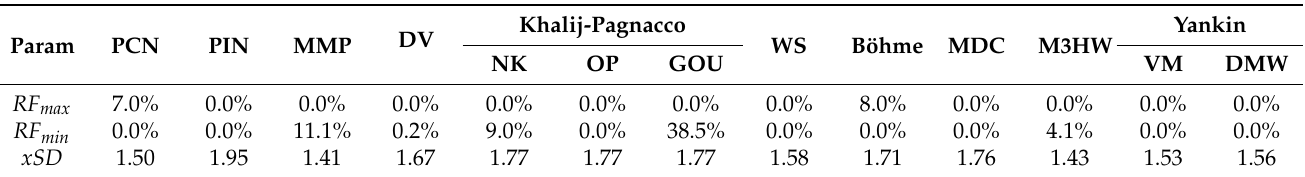
Table 14. Evaluation of the impact of the reduction in data set content from the FatLim set to the AMSD25 data